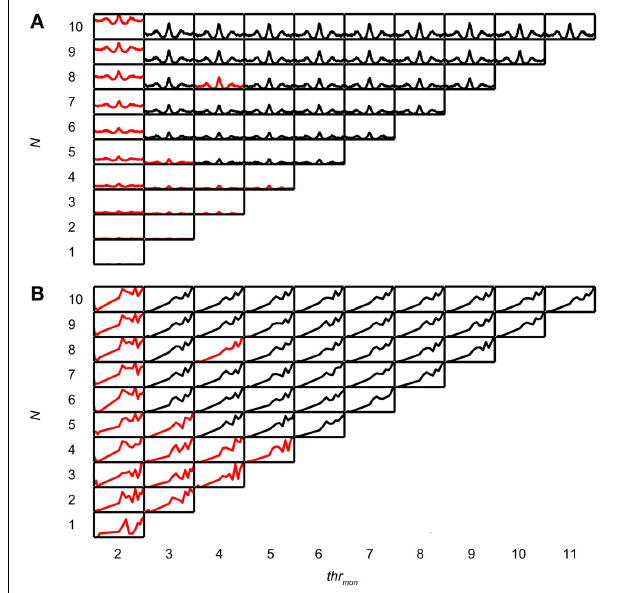
FIGURE 5 | Simulation output for AN dataset. CF = 544Hz. thr bin = 2 and cw =50 μ s. (A) NDFs to correlated noise of simulations for one AN dataset, for several N and thr mon . For each subplot, delay (abscissa) ranges from − 2.94 to 2.94ms, and coincidence rate (ordinate) ranges from 0 to 125 spikes/s. (B) rICFs for the same dataset and simulation parameters as in (A) . For each subplot, the abscissa ranges from ρ = − 1 to 1, and the ordinate ranges from 0 to the maximal spike rate of each